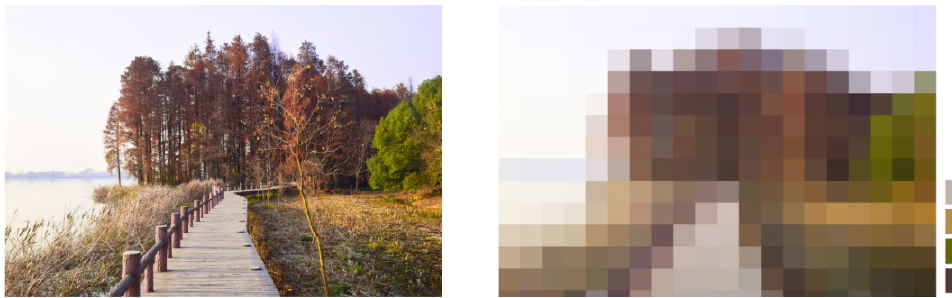
Figure 3. The extraction of main colors from the sample photo. Table 3. Descriptions of visual characteristics.